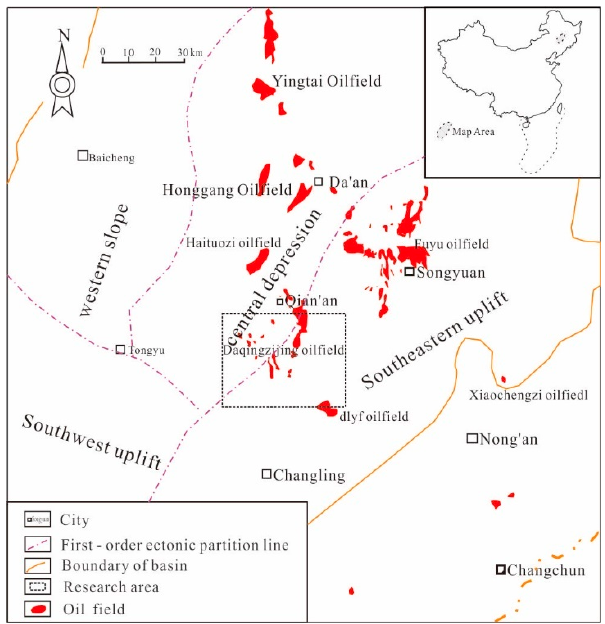
Figure 1. The regional tectonic location of Daqingzijing Oilfield [4,5].